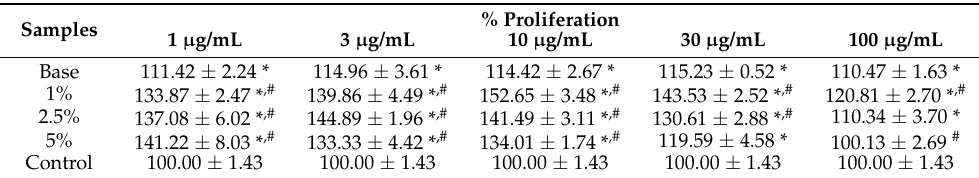
Table 8. Effect of the microemulsion base and microemulsions containing PRE at various concentra- tions on HGF cell proliferation.